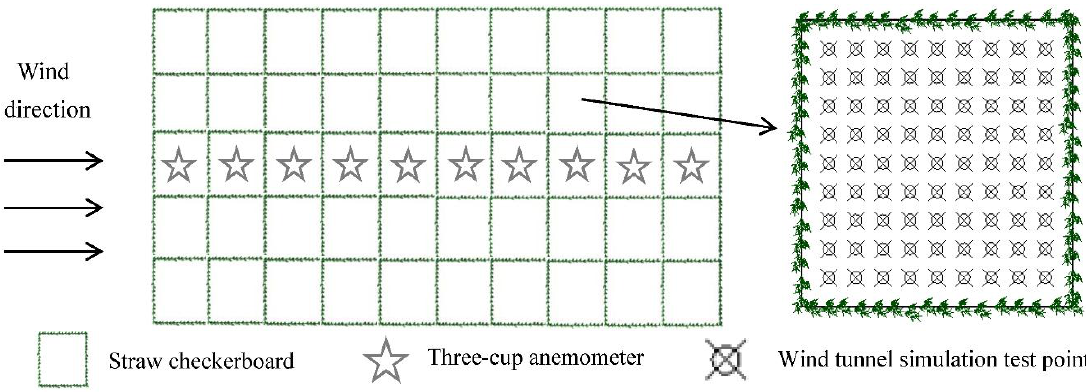
Figure 2. Schematic diagram of the measurement points within a grid.